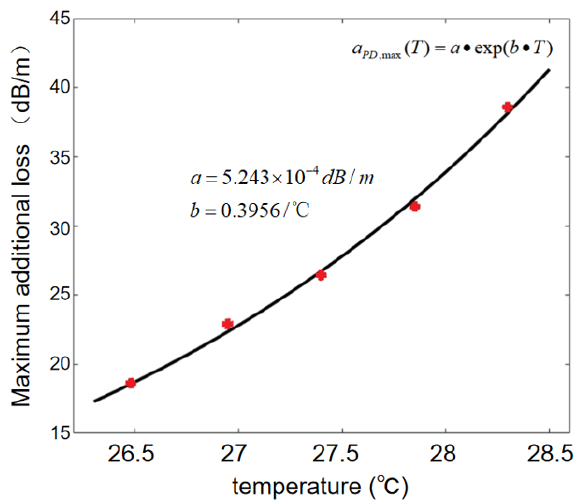
Figure 9. Additional loss under different pump power.